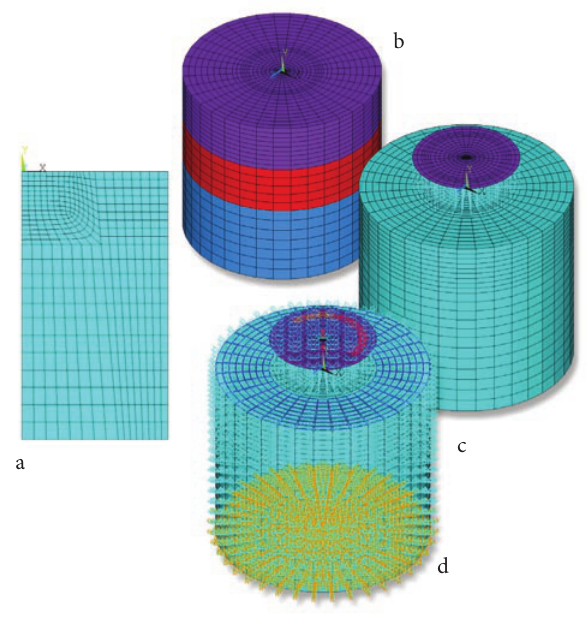
Fig. 6. Preparatory and intermediate phases of modeling: a – the planar profile discretized by the MESH200 finite elements; b – foundation of the solid of revolution; c – the system “structure-foundation”; d – the final finite element model with boundary